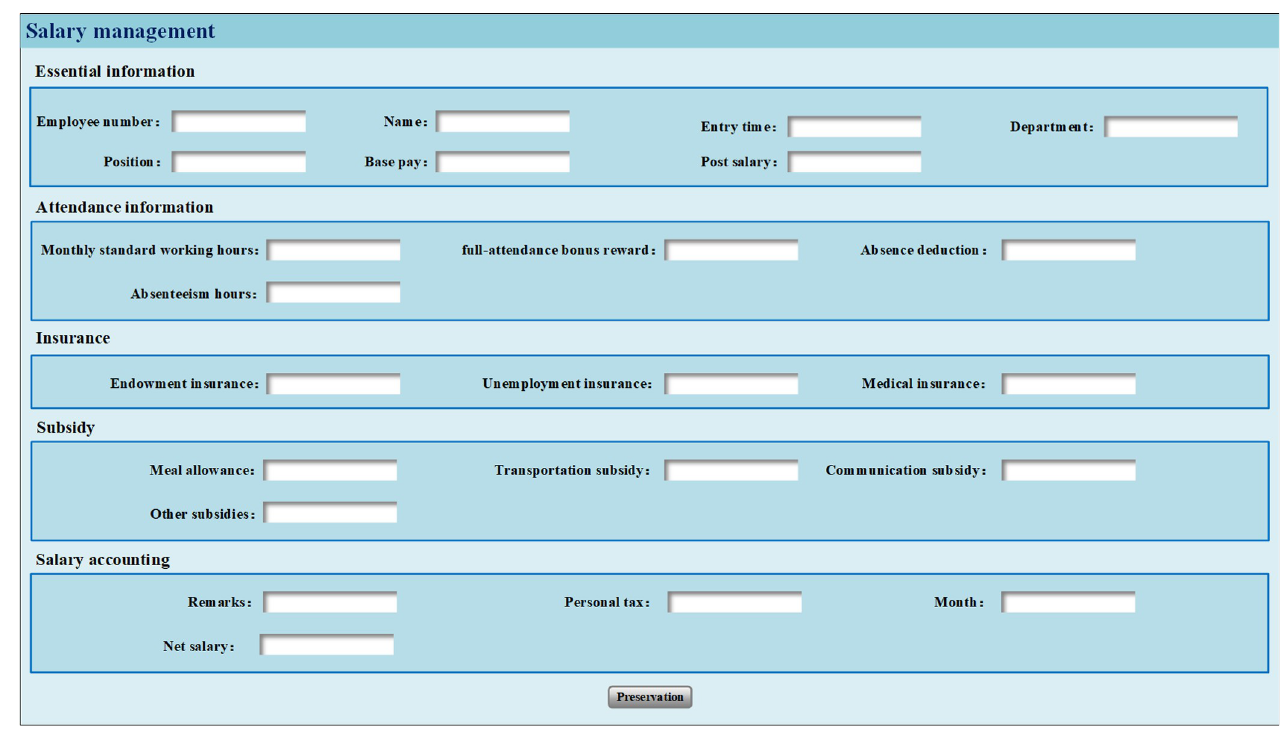
Fig 16. The interface of the salary